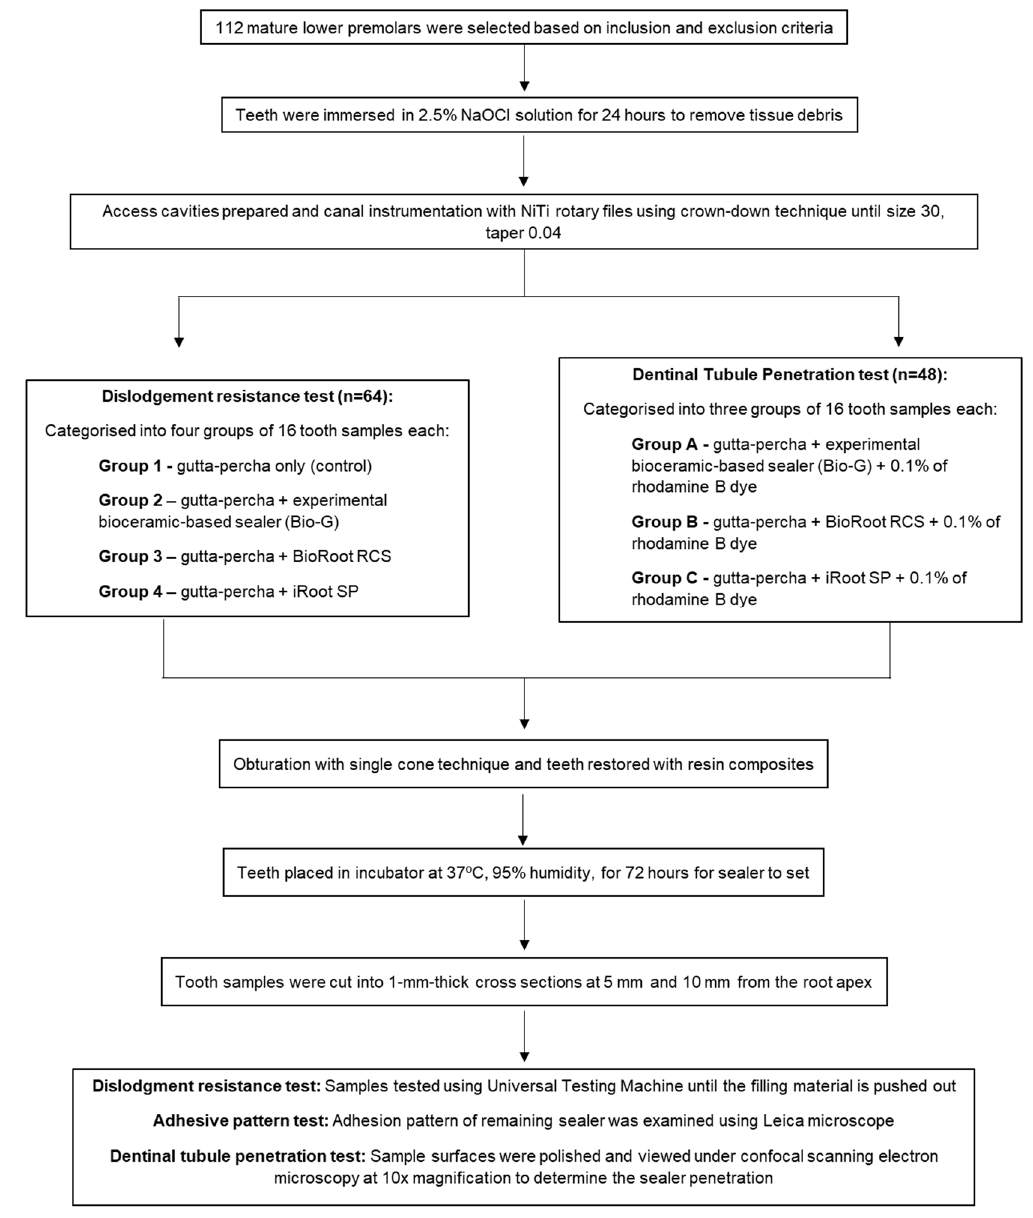
Figure 1. Flowchart of the current study.